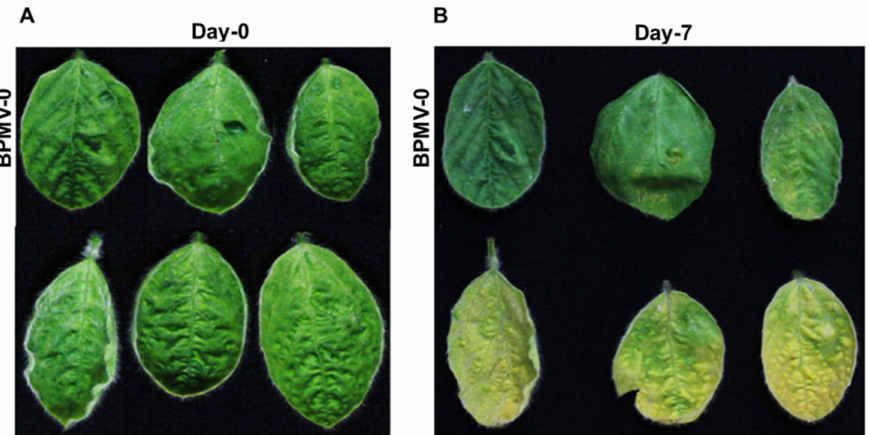
Figure 2. An accelerated senescence phenotype was observed on the leaves of the GmATG2 -silenced plants treated under dark. ( A ) Comparison of the BPMV-0 leaves with the BPMV- GmATG2 leaves before dark treatment; ( B ) comparison of BPMV-0 leaves with the BPMV- GmATG2 leaves treated under dark for 7 days. This experiment was repeated 4 times with similar result. At least 3 plants were used in each